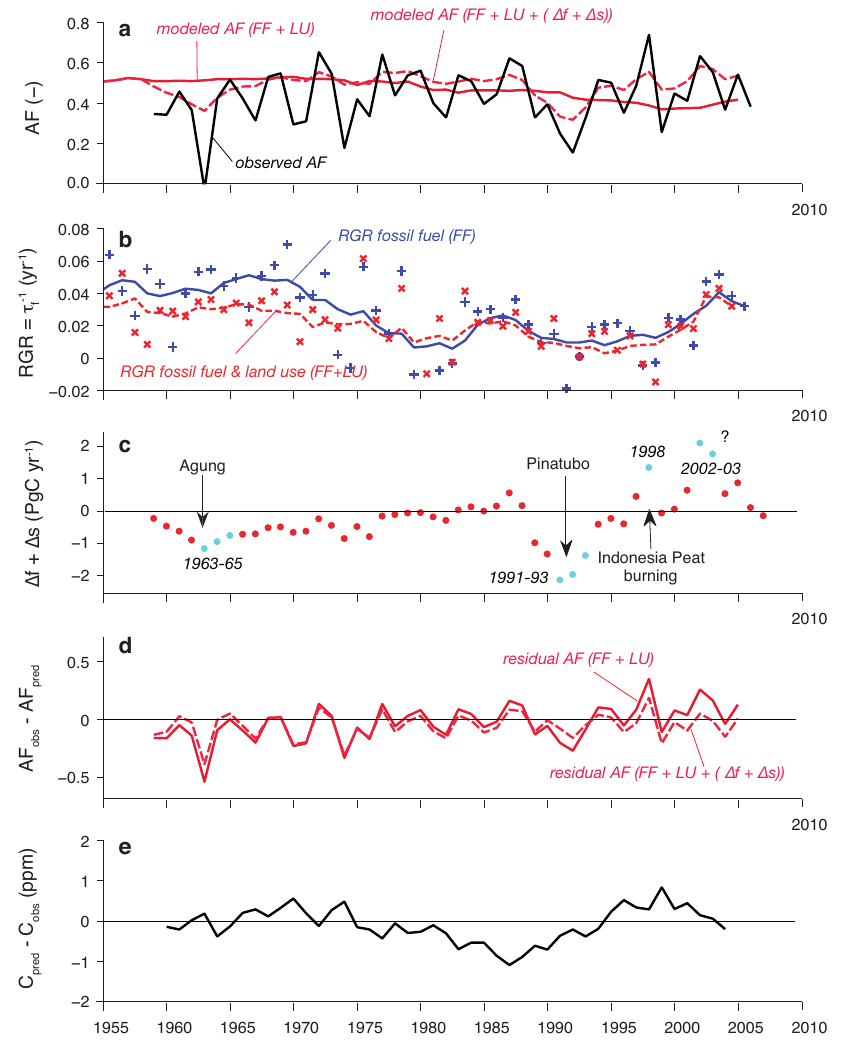
Fig. 3. Time-series from 1955 through 2010: (a) model predicted and observed AF FF + LU . Also shown is the model-predicted AF after the addition of the “corrections” shown in (c) , (b) relative growth rate of f =FF and f =FF+LU, respectively. Shown are the annual values (symbols) and after filtering it with a low-pass filter (11 year running mean); (c) correction to land use and fossil fuel emissions 1f + 1s calculated by minimizing the least square difference between predicted and observed AF FF + LU . Periods with known extrinsic forcings are indicated with arrows. (d) Difference between observed and model predicted AF FF + LU and AF FF + LU + 1(f + s) , and (e) difference between predicted and observed atmospheric CO 2 .